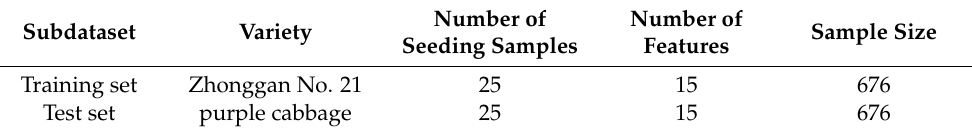
Table 1. Nursery dataset containing 15 characteristic values: seedling height (mm), leaf expansion (mm), stem thickness (mm), number of leaves (pieces), length of the first leaf (mm), width of the first leaf (mm), length of the second leaf (mm), the width of the second leaf (mm), length of the third leaf (mm), width of the third leaf (mm), length of the fourth leaf (mm), width of the fourth leaf (mm), air temperature ( ◦ C), air relative humidity (RH), and light intensity (lx). Number of Number of Subdataset Variety Sample Size Seeding Samples Features Training set Zhonggan No. 21 25 15 676 Test set purple cabbage 25 15